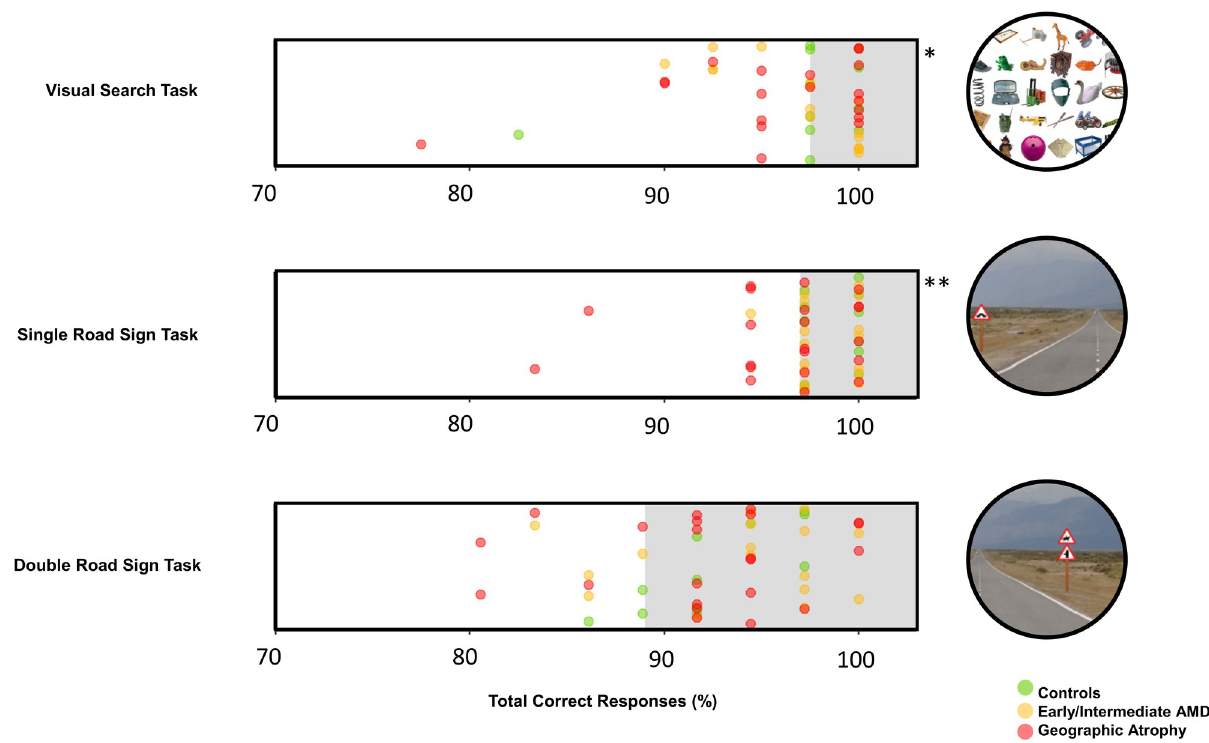
Fig 3. Plot of median total correct responses. The total correct responses (%) of the three participant cohorts with respect to the normative limit shown as the shaded area. The limit for the visual search task was 98%, for the single road sign task was 97% and for the double road sign task was 89%. � Two participants from the GA group have been omitted as the axis was truncated at 70%. TCRs were 13% and 33%. �� One participant from the GA group was omitted, TCR was